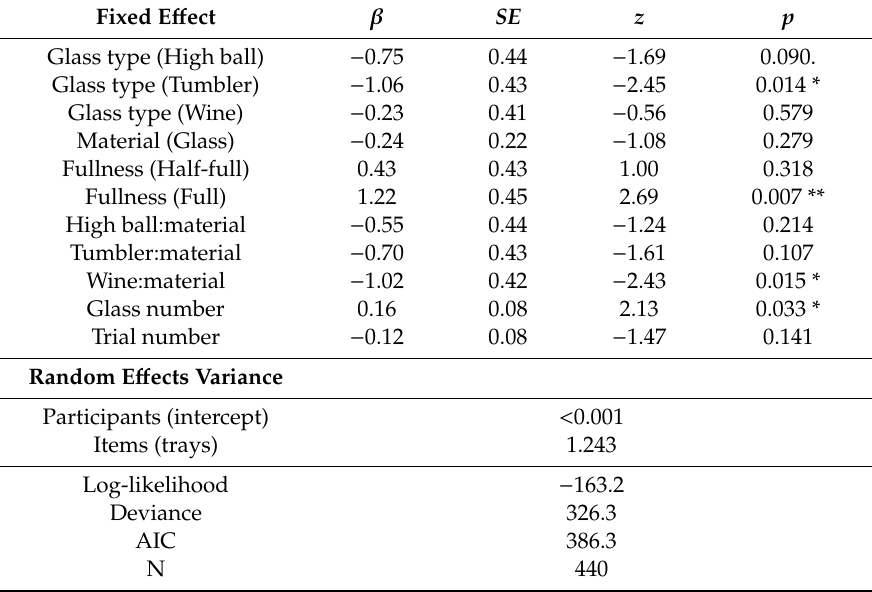
Table 3. GLMM output for fully vs. partially visually-guided putdowns during putdown 2 (on the tray). Structure of model reported here: glmer(visual guidance type ~glass type*material + fullness